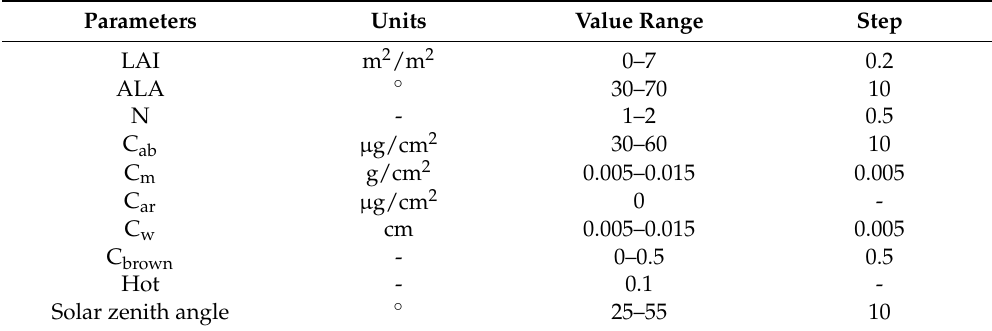
Table 3. The input variables of PROSAIL model for LAI estimation algorithm development.